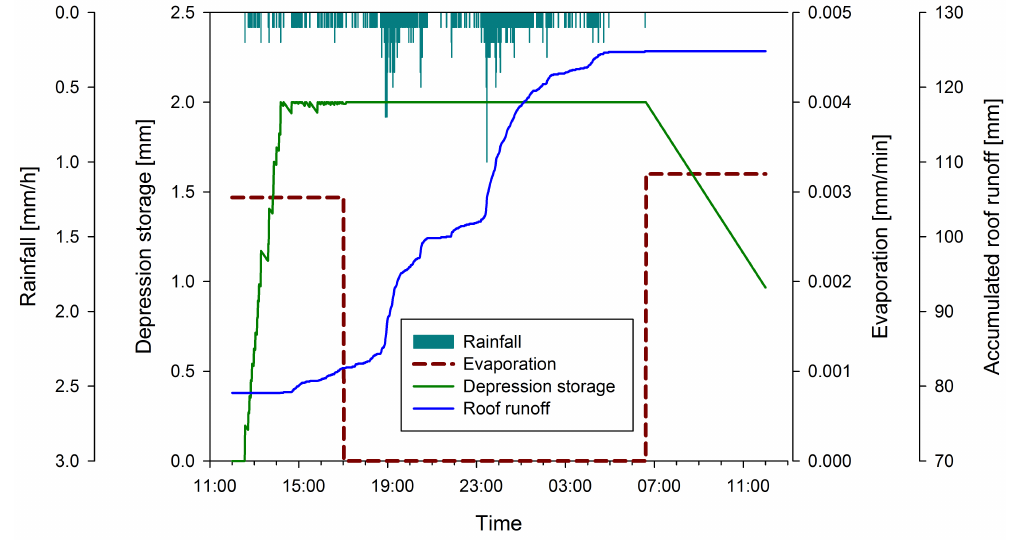
Fig. 4. Example of continuous one-minute modelling of rooftop harvesting; largest event on record, station Library, 20–21 January